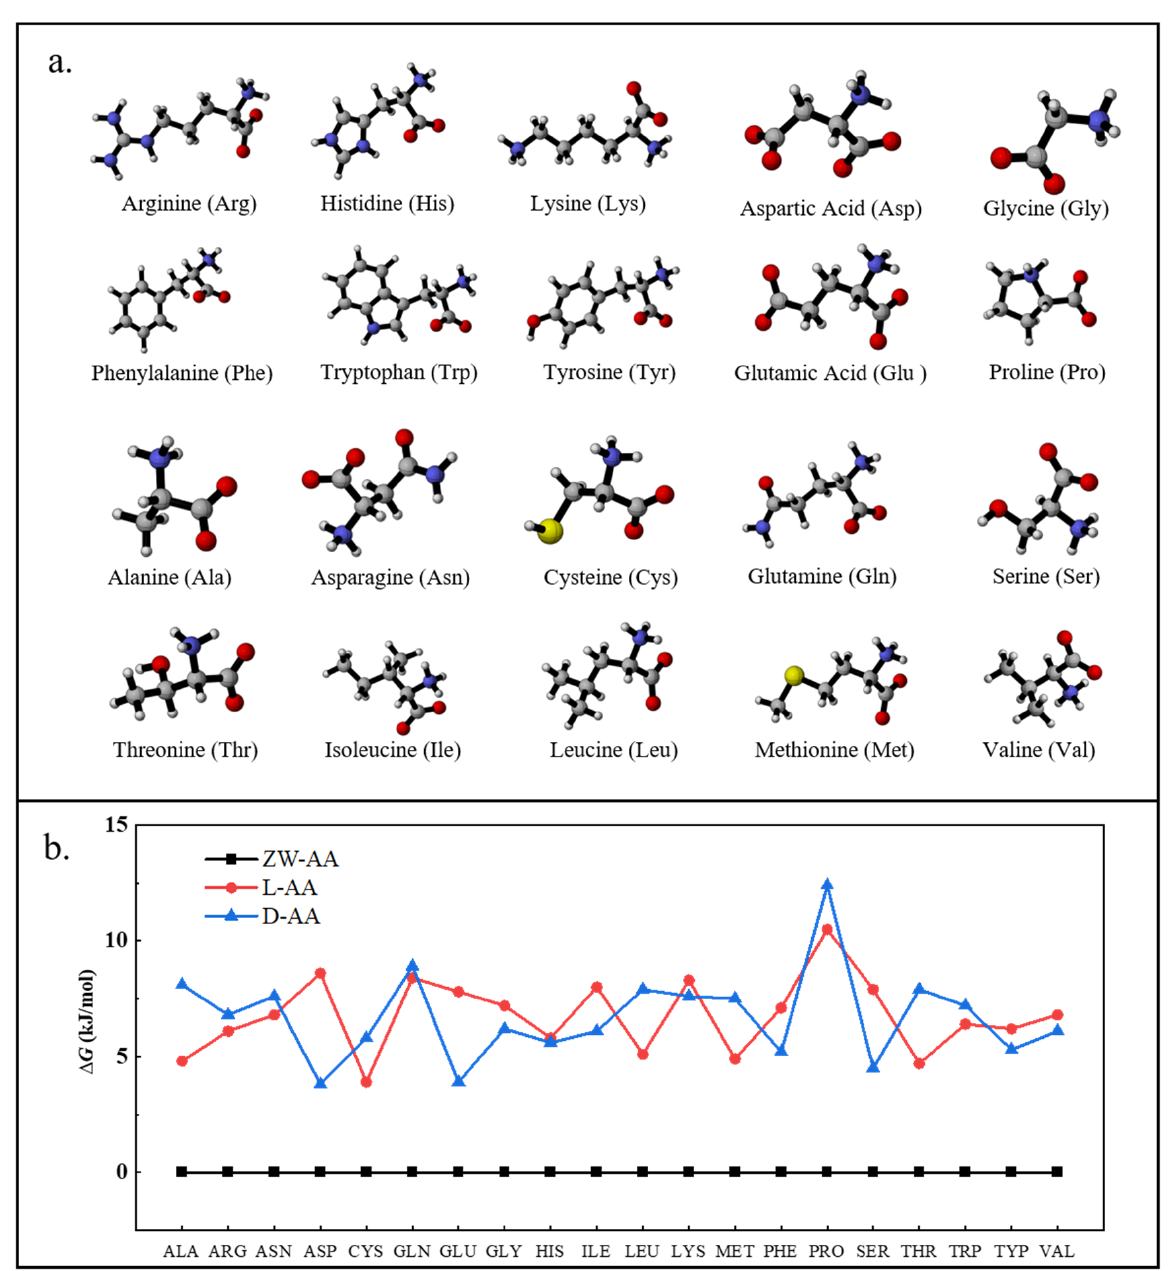
Figure 1. The stable configurations of 20 amino acids in a zwitterionic state ( a ) and the relative free energies ( ∆ G ) of 20 amino acids ( b ), including zwitterionic states (ZW-AA), left-handed natural AA (L-AA) and right -handed natural AA (D-AA).